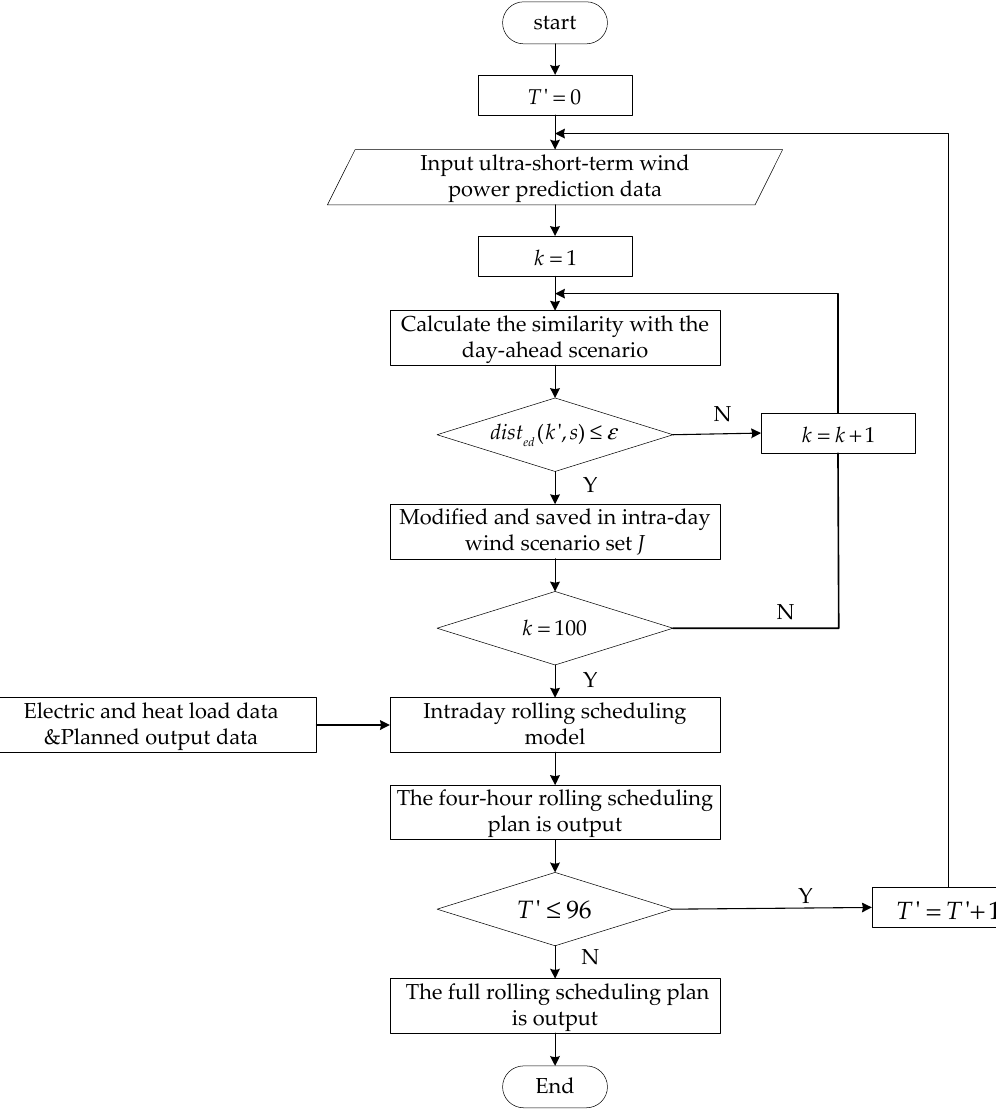
Figure 5. The calculating procedures for intra-day rolling optimization scheduling model.